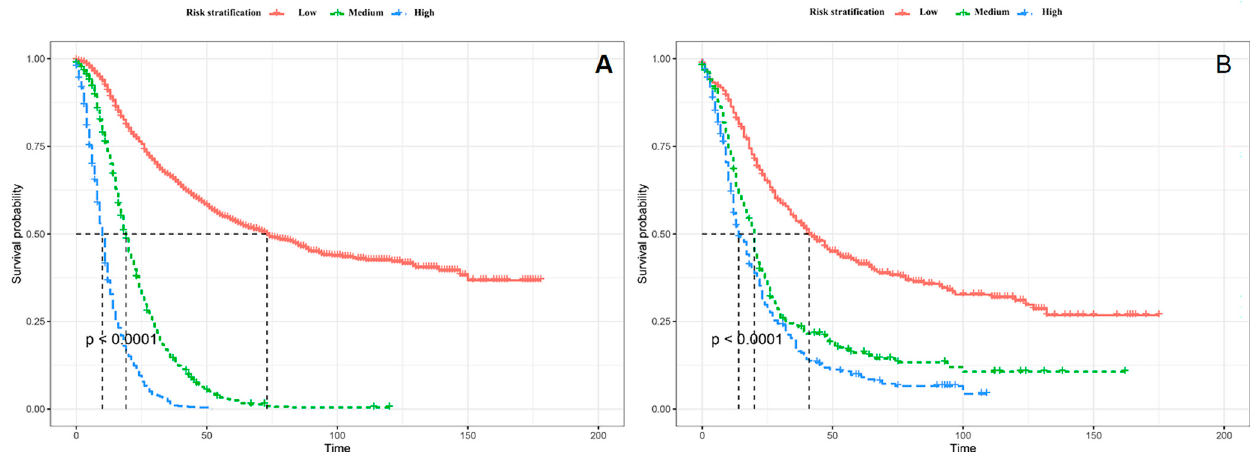
Figure 5. The RSF risk stratification patients. ( A ). The RSF risk stratification of patients in the training set. ( B ). The RSF risk stratification of patients in the test set.